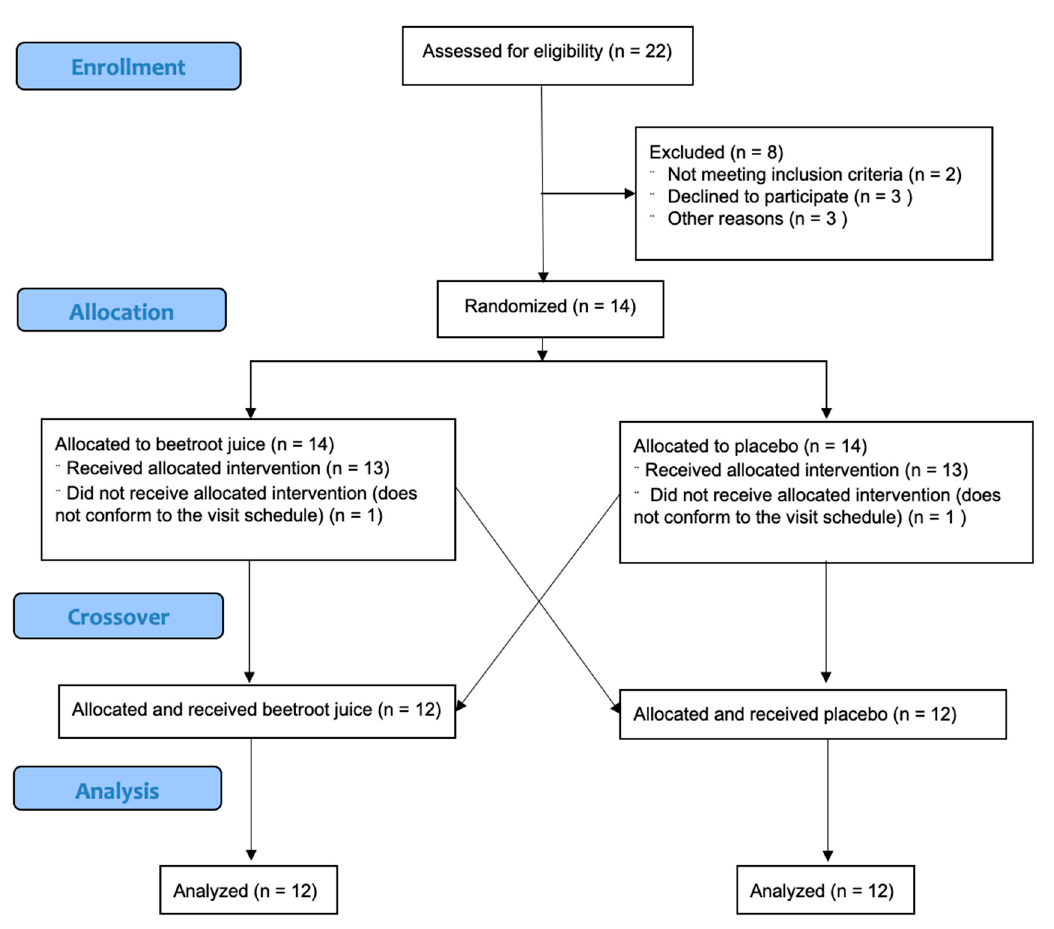
Figure 1. CONSORT Figure 1. CONSORT diagram.